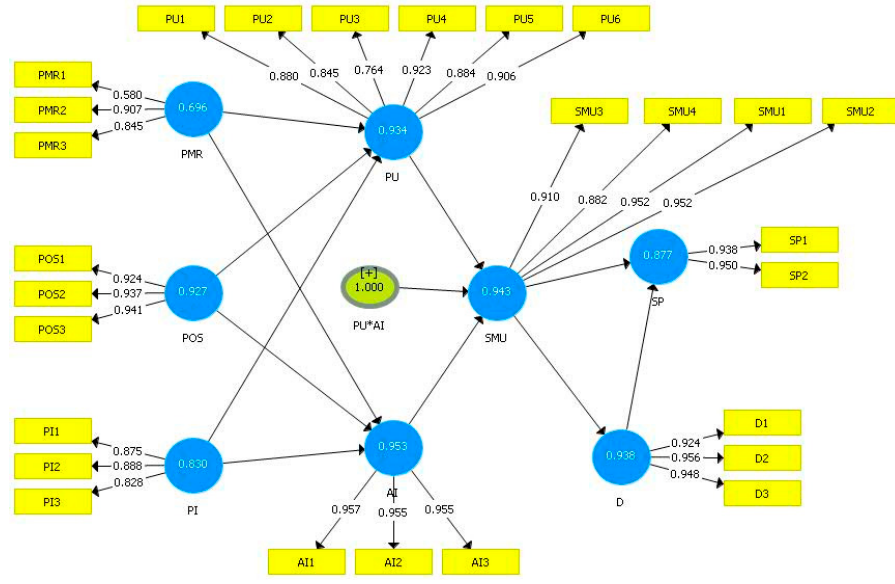
Figure 3. SmartPLS software output for Cronbach’s alpha coefficient values. Table 4. Cronbach’s alpha coefficient values for observed